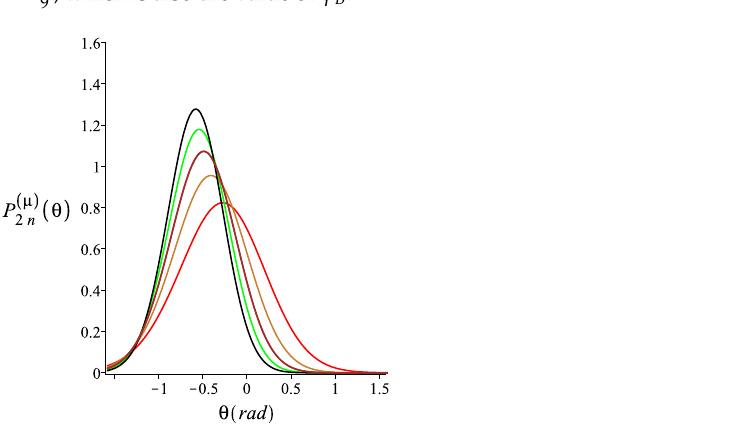
Figure 5. The probability density of the orientation of the free endpoint of the grafted structure with an even number of arms. The red, gold, brown, green, and black are associated with the fixed values = 12.5 i , where i = 1,2,3,4,5, respectively. The other fixed parameters for the stiffness parameter, l p L are: ω = π , φ µ = 0, φ B = 0 n = 2, K B = 3. 4